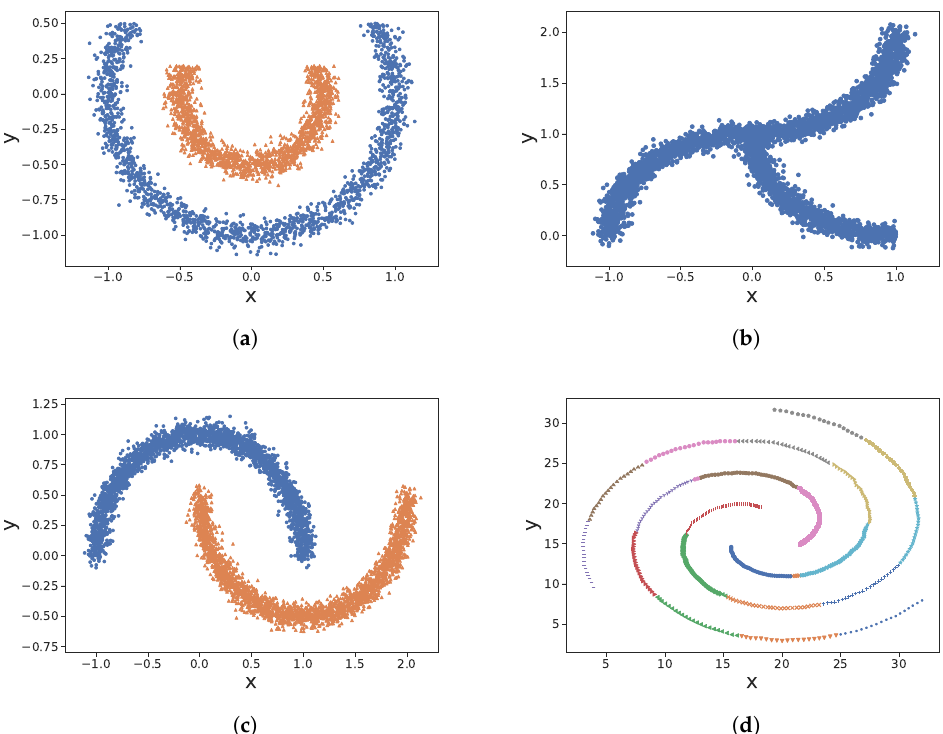
Figure 16. Clustering using DenStream algorithm. ( a ) Clustering with the Horseshoe dataset; ( b ) Clustering with the T dataset; ( c ) Clustering with the Moon dataset; ( d ) Clustering with the Three Spirals